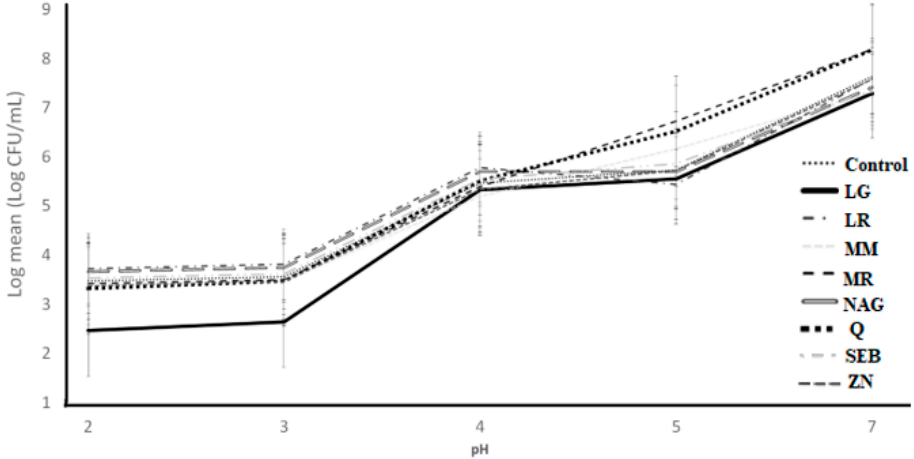
Figure 7. Log counts of Streptococcus thermophilus showing its resistance to simulated gastric juice as influenced by ingredients over different pH conditions. C = control, LG = L-glutamine (7 g/L), Q = quercetin (700 mg/L), SEB = slippery elm bark (210 mg/L), MR = marshmallow root (1340 mg/L), NAG = N-acetyl-D-glucosamine (210 mg/L), LR = licorice root (210 mg/L), MM = maitake mushrooms (42 mg/L), and ZN = zinc orotate (70 mg/L). Error bars represent SE.